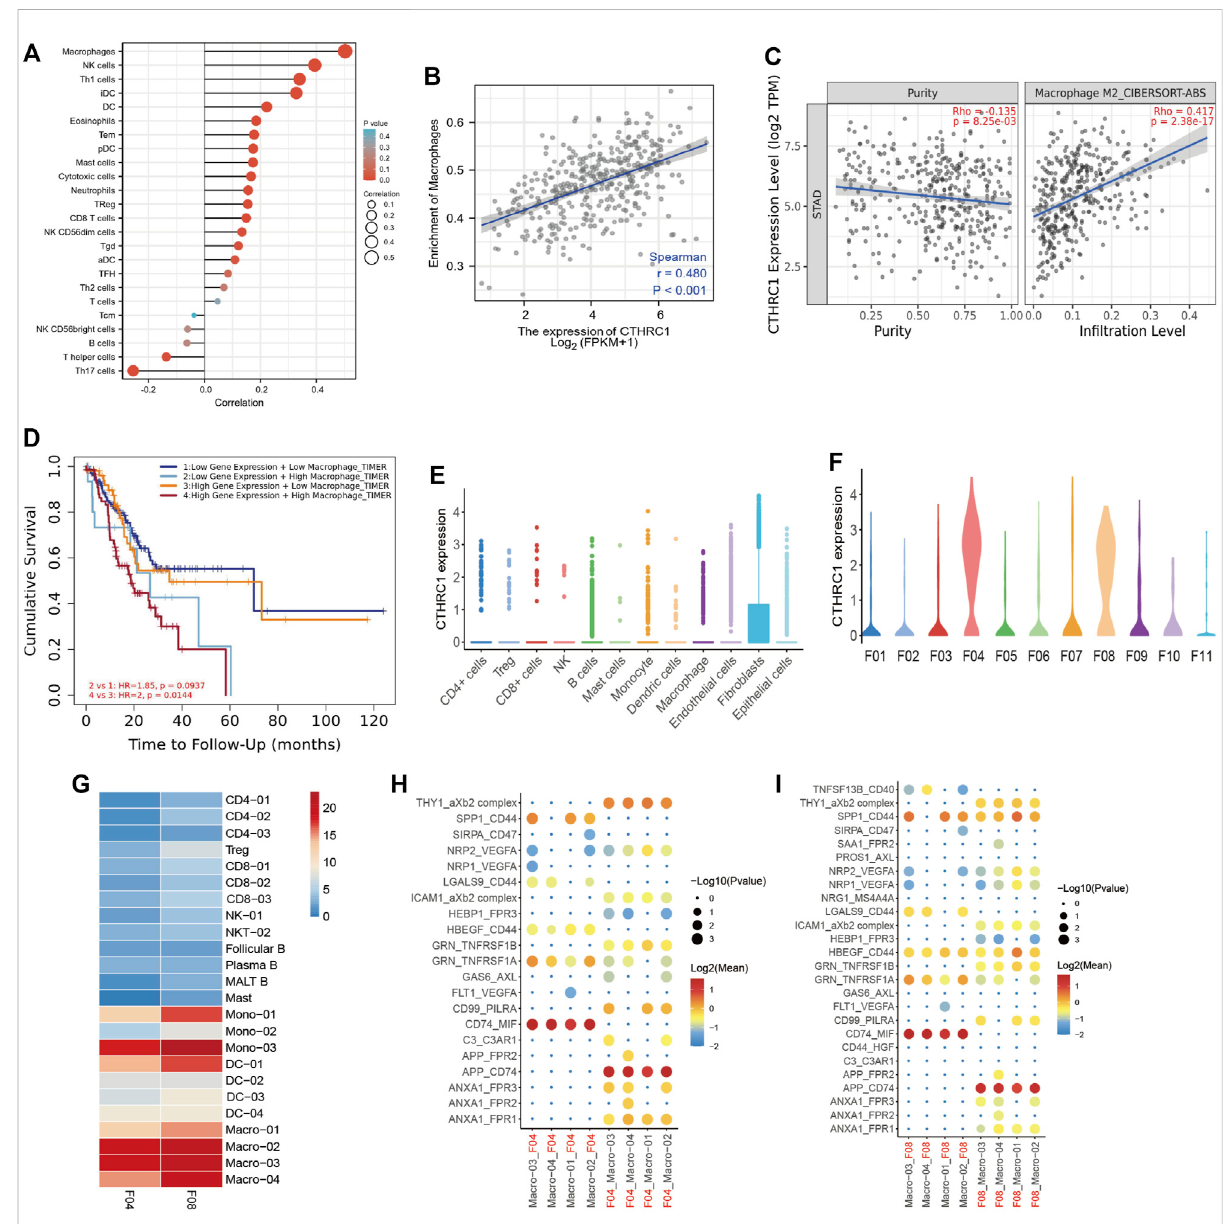
FIGURE 4 CTHRC1 expression and macrophages in fi ltration. (A) The expression level of CTHRC1 was associated with the immune in fi ltration in gastric cancer. (B) CTHRC1 expression signi fi cantly positively correlated with the macrophage in fi ltration, and (C) M2 macrophage in fi ltration. (D) Kaplan- Meier survival curves comparing the high and low expression of macrophages in fi ltration and CTHRC1 expression. (E) The CTHRC1 expression in differentcelltypesingastriccancerusingsinglecellRNAsequencing. (F) TheCTHRC1expressionindifferent fi broblastclustersingastriccancer using single cell RNA sequencing. (G) The cell interaction between tumor cells from F04 and F08 and immune cells. (H – I) The ligand-receptor pairs between tumor cells from F04 and F08 and immune